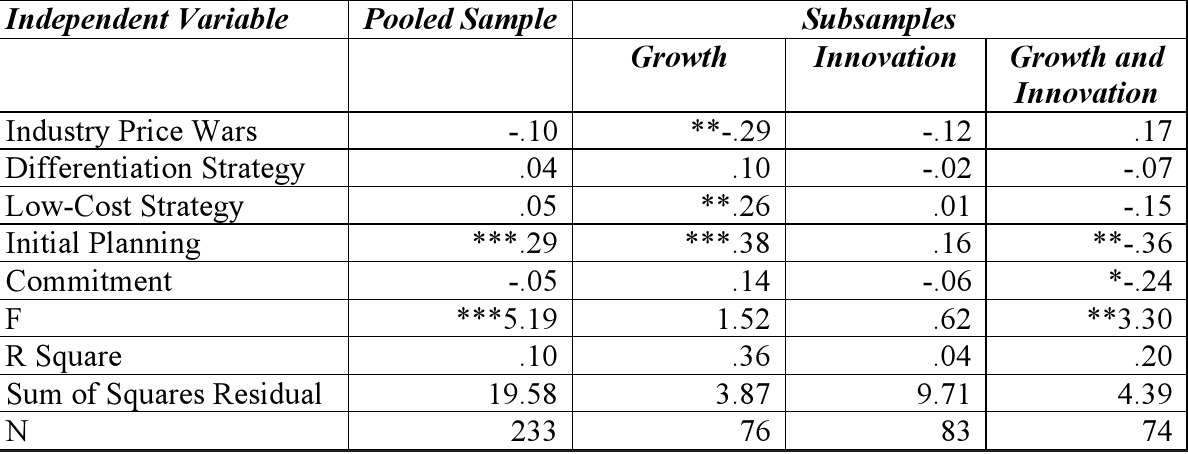
Table 4. Illustrative Regression Results: Regression of Independent Variables on Debt-to-Assets by Subsample (Growth, Innovation, and Growth and